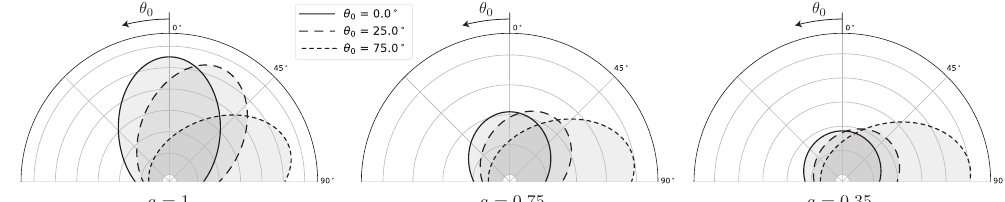
Figure 4. Impact of the a -parameter on the incidence-angle dependency of the BRDF representation defined in (10). ( t = 0.4).